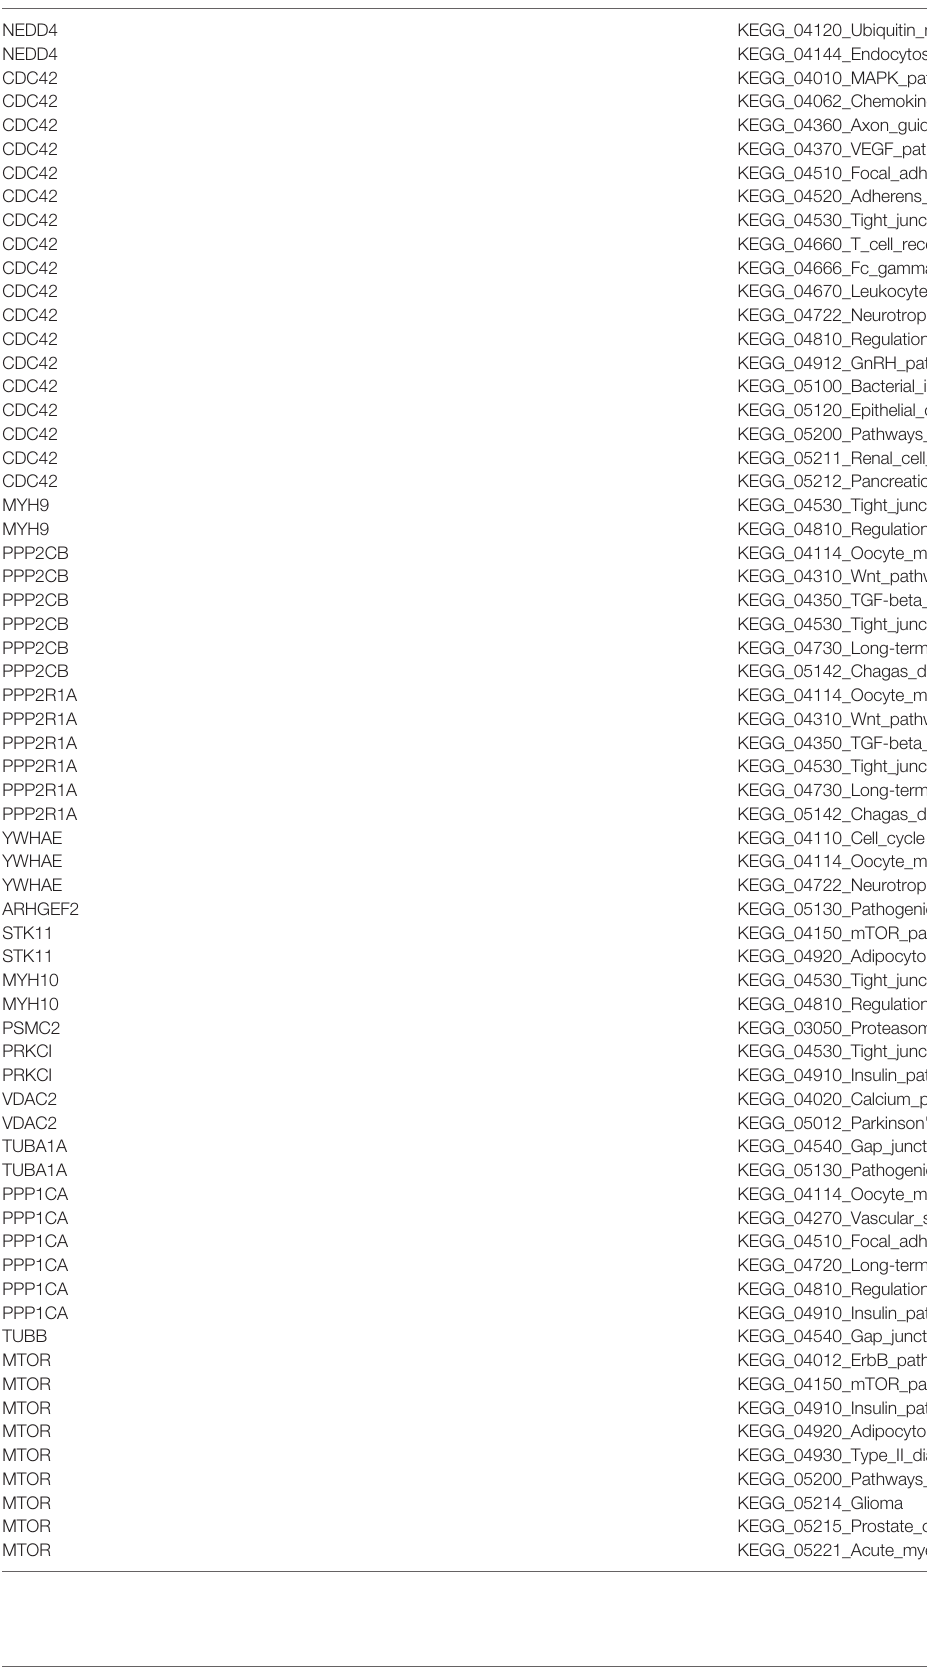
TABLE 1 | MARK4-interactors-associated